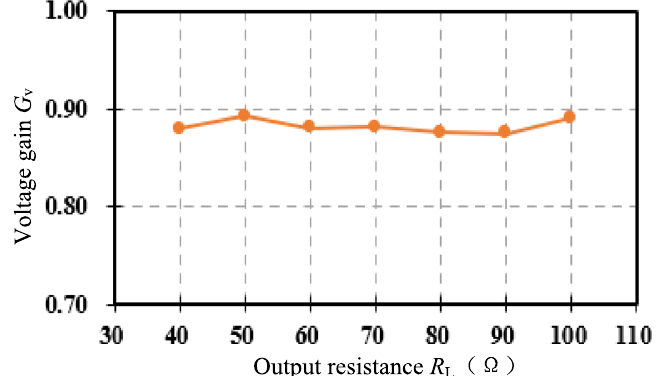
Figure 20. Voltage gain under compound control.